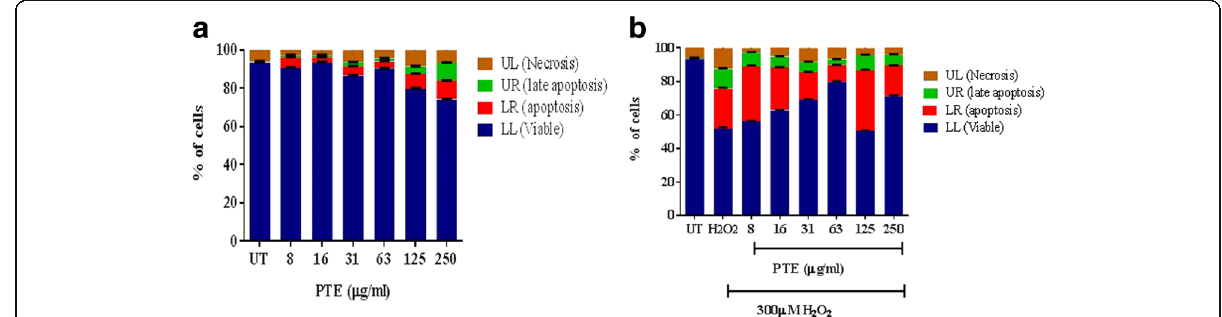
Fig. 4 a Effect of PTE treatment for 24 h on dIMR32 cells apoptosis. b Effect of PTE pre-treatment (24 h) against H 2 O 2 induced apoptosis in dIMR32 cells. The data are expressed as mean ± SEM, n = 3. The label UT = untreated control cells. Statistical significance was analyzed with one way ANOVA followed by Dunnett ’ s multiple comparison post-hoc test. There was significant differences with the number of apoptotic cells between 300 μ M H 2 O 2 treated cells and PTE pre-treated cells for all the tested concentration with p <